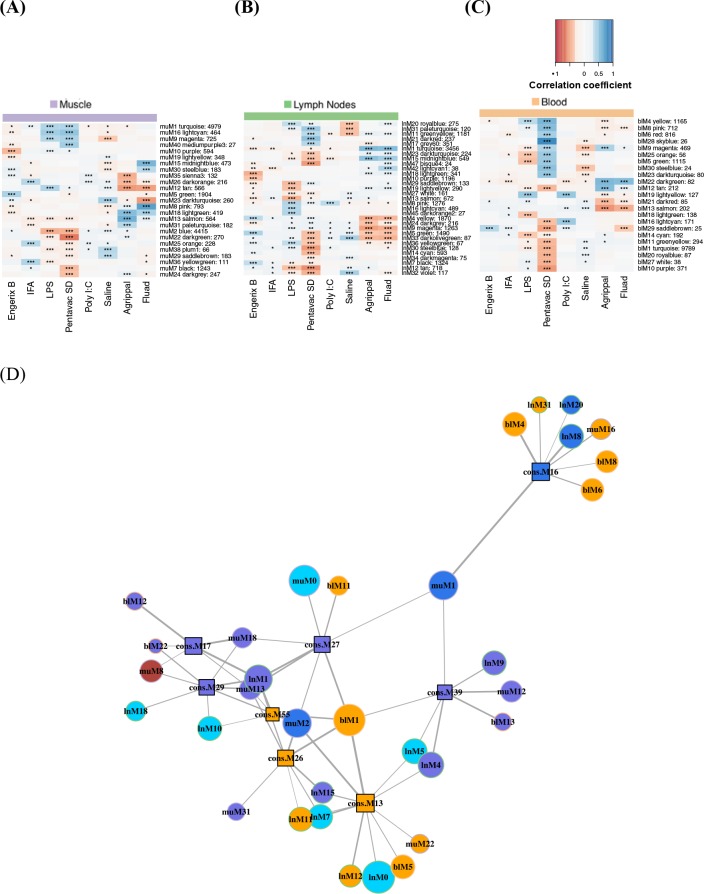
Weighted gene co-expression network analysis of module–trait relationships.Modules extracted by co-expression analyses in the injected muscle (A), draining lymph nodes (B), and blood (C) datasets are in rows labelled with a colour for each treatment and an identificaton number. The number of genes contained in the given module is also listed after the identification numbers. The heatmaps are colour coded by the Pearson correlation coefficient between the given module eigengene and the trait (r > 0.3 in blue and r < −0.3 in red, *p<0.01, **p<0.001, ***p<0.0001; see legend above heatmaps). (D) Consensus modules (square-shaped nodes) across the different tissue datasets are represented in a network diagram. Nodes are scaled to the module size and coloured by their strongest associated trait, with Engerix B in light blue, Agrippal in purple, Fluad in red, Pentavac SD in orange and LPS in dark blue. The thickness of the lines is scaled to the number of genes shared between the connected modules. Modules are connected if they share more than four genes, and connected modules that are not associated with a trait are not shown (absolute correlation coefficient r < 0.35).